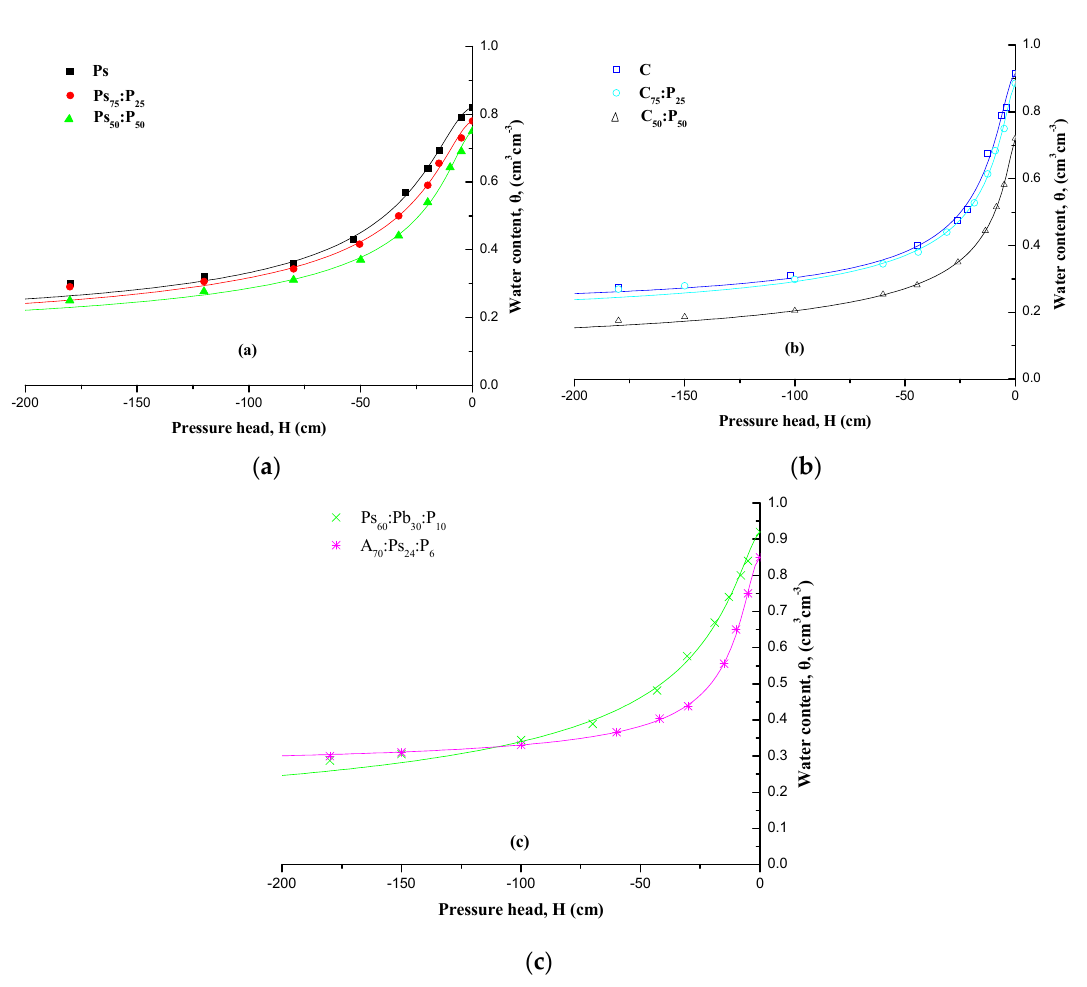
Figure 1. Experimental water retention data (symbols) and predicted curves (lines) obtained by the Mualem–van Genuchten model using the RETC program for the substrates: ( a ) 100% sphagnum peat (Ps); 75% sphagnum peat and 25% perlite (Ps 75 :P 25 ); 50% sphagnum peat and 50% perlite (Ps 50 :P 50 ); ( b ) 100% coir (C); 75% coir and 25% perlite (C 75 :P 25 ); 50% coir and 50% perlite (C 50 :P 50 ); ( c ) 60% sphagnum peat, 30% black peat, and 10% perlite (Ps 60 :Pb 30 :P 10 ); and 70% Arbutus soil, 24% sphagnum peat, and 6% perlite (A 70 :Ps 24 :P 6 ). Values are the means of three replications ( n = 3). Table 3. The Mualem–van Genuchten model fitting parameters α , n , θ r and measured values of θ s for the